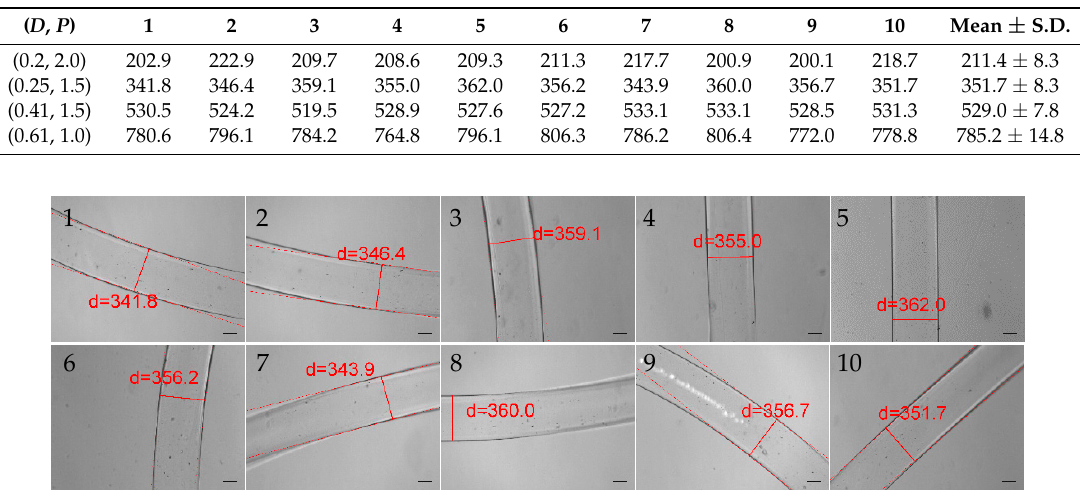
Figure 2. The measured diameters at the 10 positions of the hydrogel fiber fabricated in the configuration of (0.25, 1.5). The scale bar is 100 μ m.